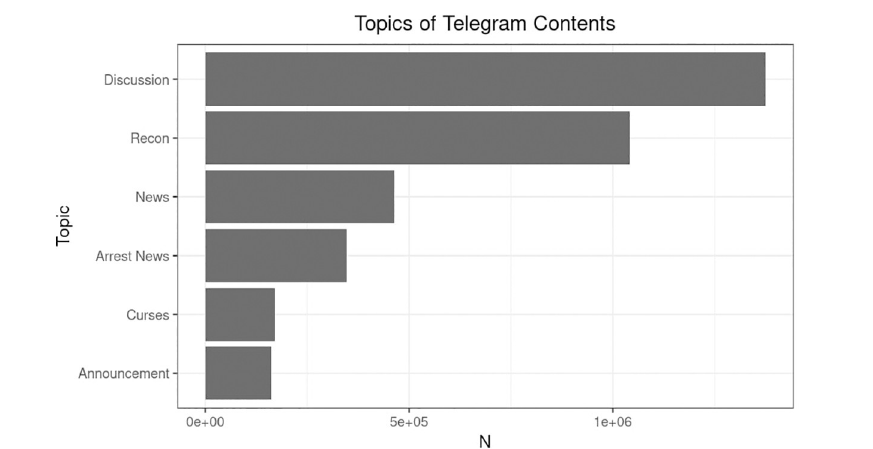
Fig 5. Prevalence of topics in the analyzed Telegram content.